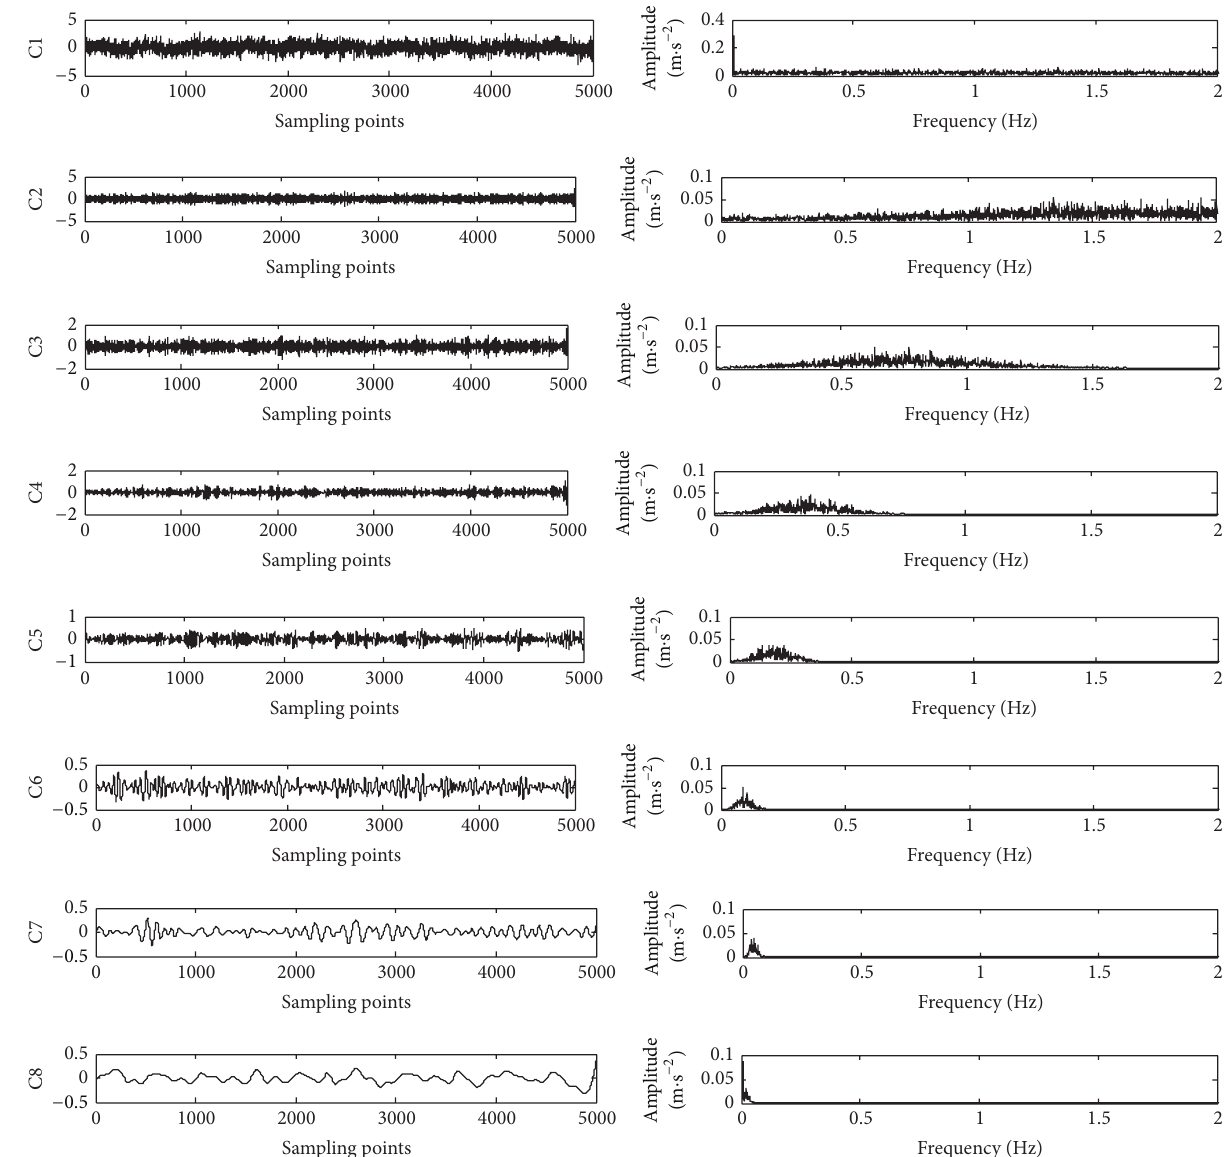
Figure 2: The EEMD components of original signal and its spectrum.